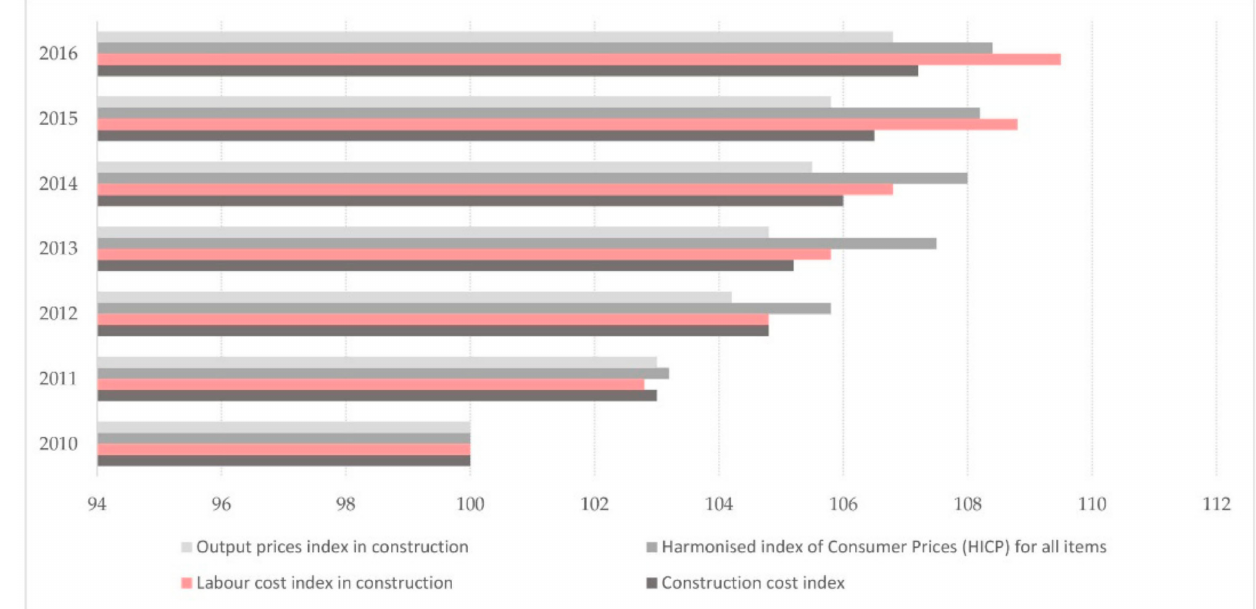
Figure 1. Construction costs index in the EU-28 between 2010 and 2017 (2010 =